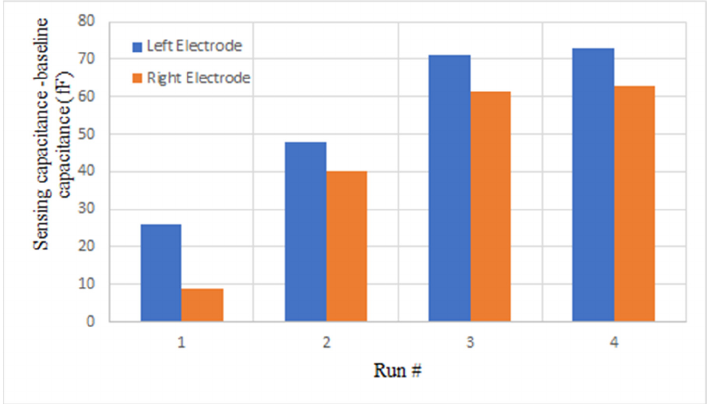
Figure 18. The difference between the capacitance after each run and the capacitance before the first run (fF) ( C AfterRun# - C BeforeRun1 ) for four consecutive runs of the first experiment for the two electrodes.